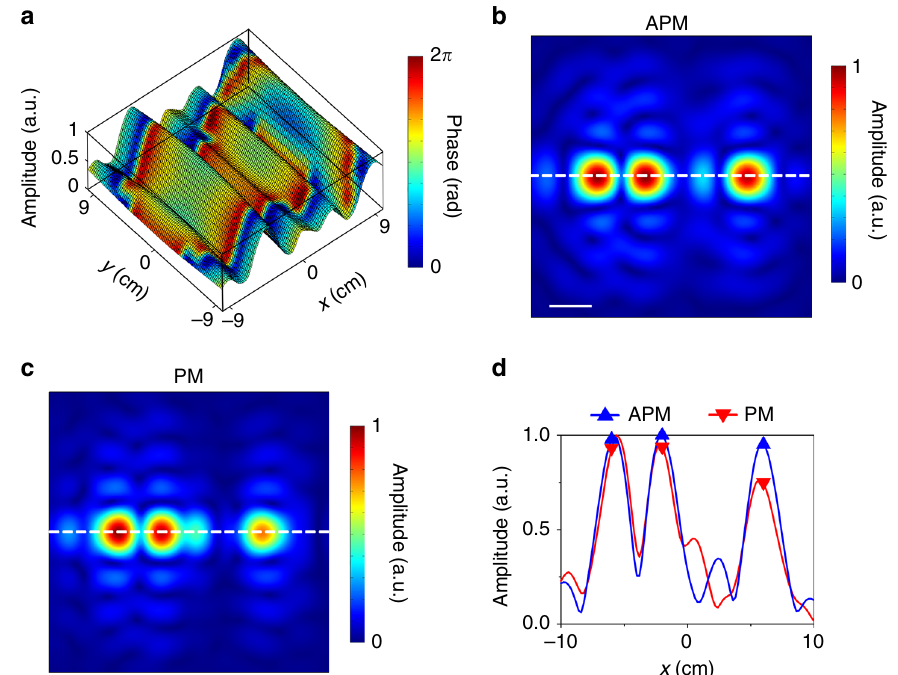
Fig. 4 Multifocal acoustic focusing. a Amplitude and phase pro fi les at the surface of the LAM for multifocal acoustic focusing. b Simulated multifocal acoustic focusing by the APM method. Scale bar, 3 cm. c Simulated multifocal acoustic focusing by the PM method. d Distributions of pressure amplitude on the dashed lines in b and c . Three target focal points are marked by